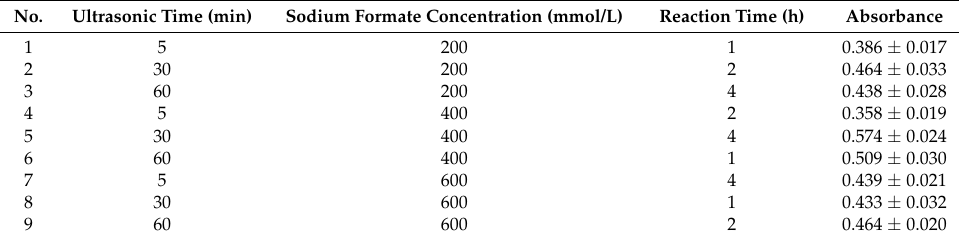
Table 2. Catalytic activity of Au/MWCNTs composites with the SQA-iron(II/III) system under orthogonal design of three factors and three levels.